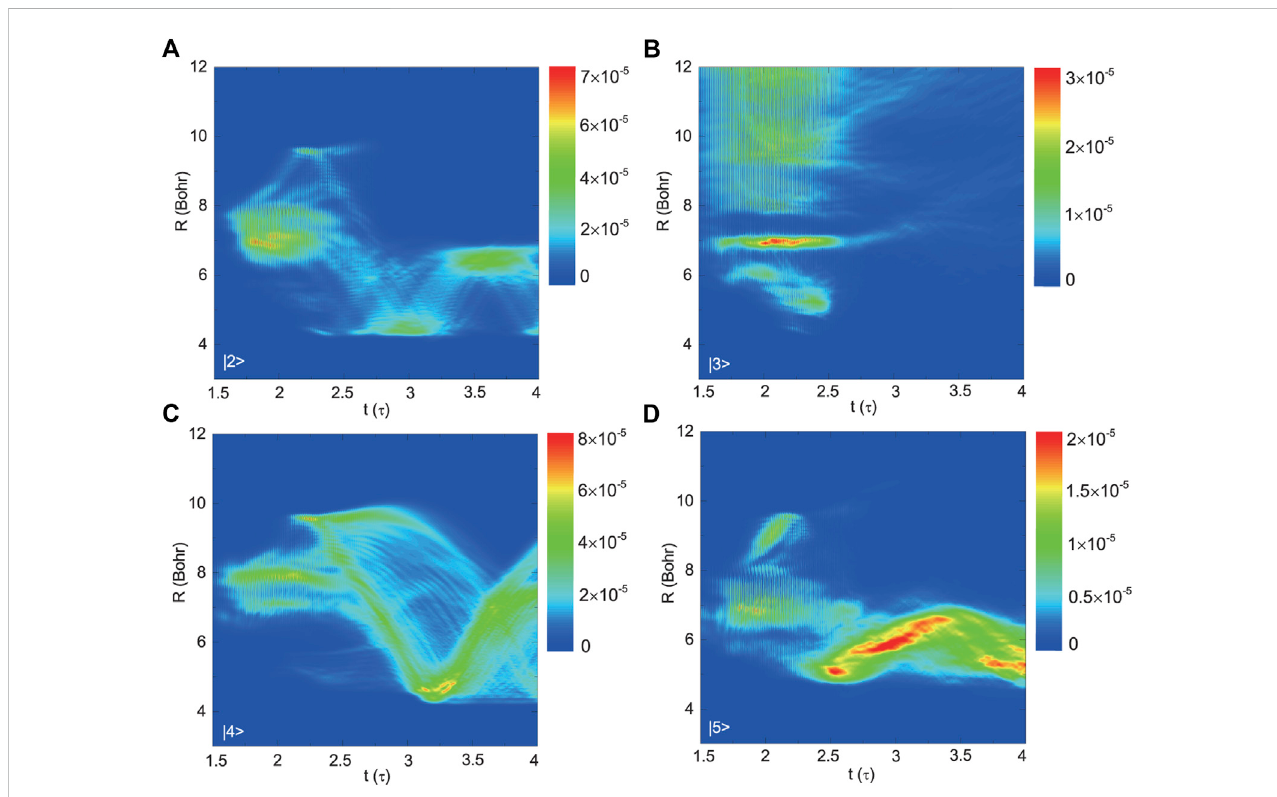
FIGURE 4 The propagations of the radial wavepackets for the four excited states, (A) |2 〉 , (B) |3 〉 , (C) |4 〉 , and (D) |5 〉 , in Case 1 with τ = 100 fs and δ t 0 =